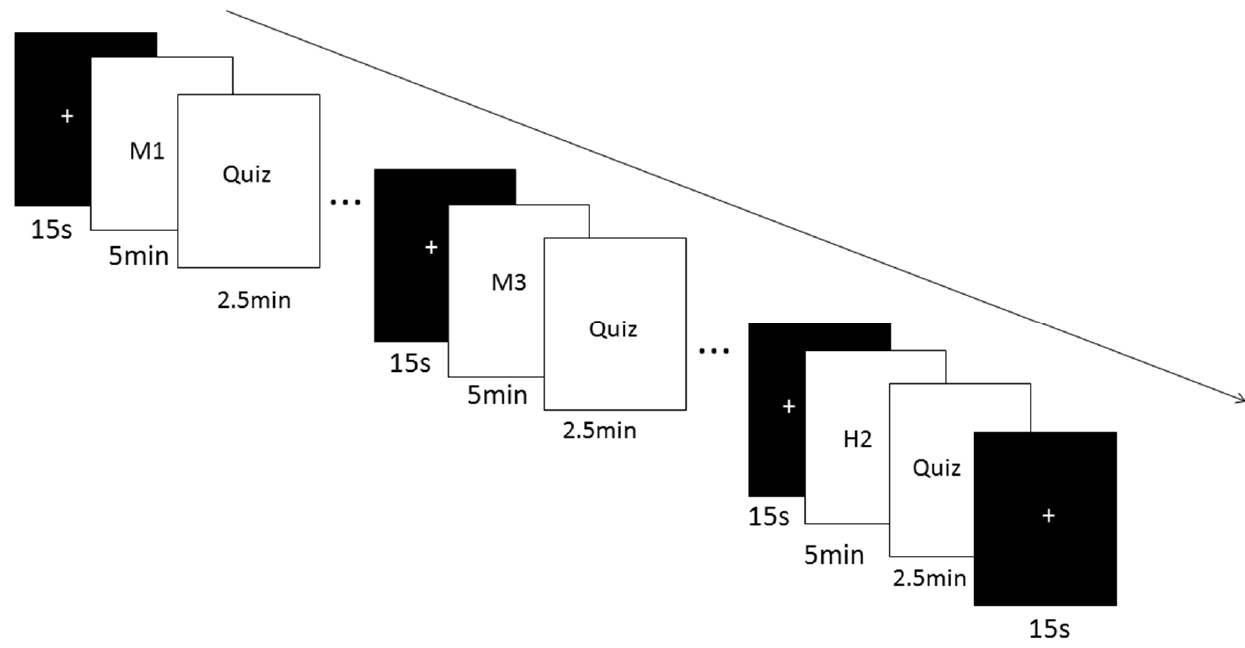
Figure 1. The experimental procedure of the formal experiment. The black screen with a white cross represents a 15 s rest. M and H mean mathematics and history micro-lectures, respectively. T means the test period.